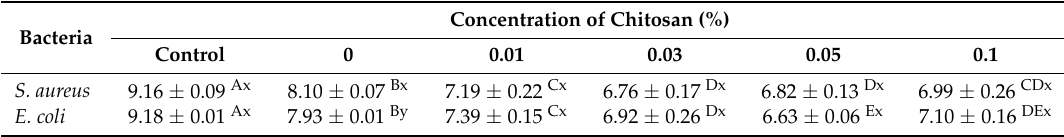
Table 4. Effect of chitosan concentration in 0.4% emulsified pomelo peel oil on the viability of S. aureus and E. coli (Log CFU/mL) a,b